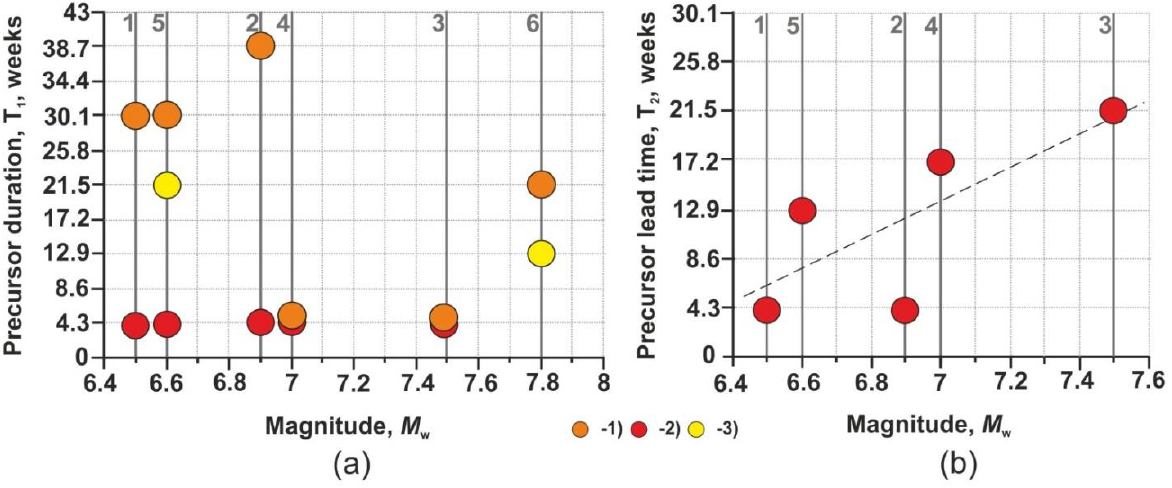
Figure 4. ( a ) Distribution of the precursor duration ( T 1 ) in observation wells: (1) GK-1, (2) M-1, (3) G-1, depending on magnitude M w of earthquakes No. 1–6 in Table 2; earthquakes are shown with gray vertical lines. ( b ) Distribution of the lead time ( T 2 ) of preseismic anomalies in well M-1 (Figure 3b), depending on magnitude M w of earthquakes No. 1–5 (linear correlation coefficient is 0.74).